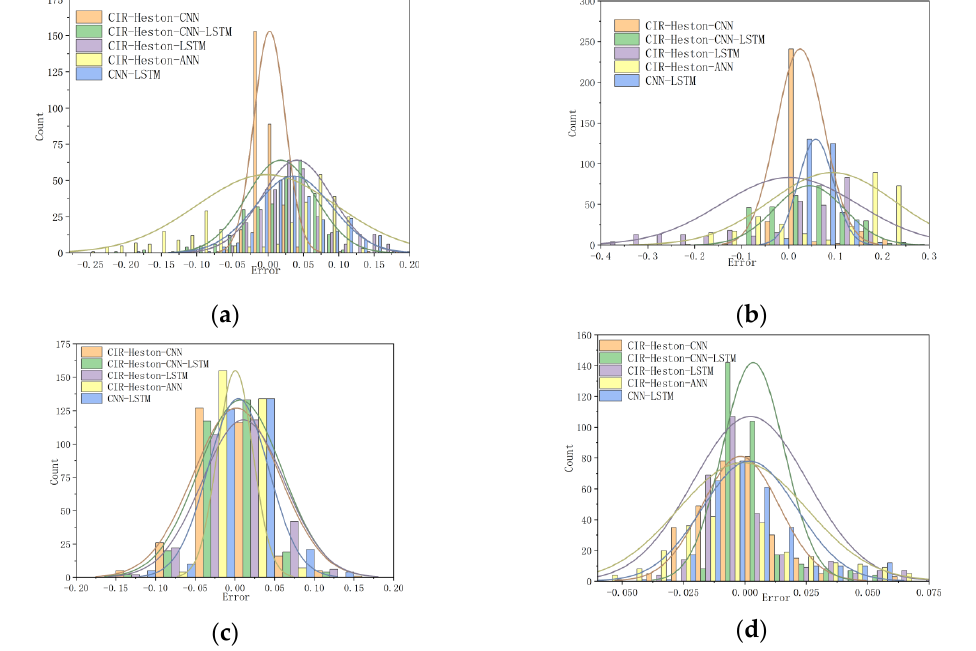
Figure 9 . Error distribution ( a ) of unnoisy call option; ( b ) of noisy ‐ up call option; ( c ) of unnoisy Figure 9. Error distribution ( a ) of unnoisy call option; ( b ) of noisy-up call option; ( c ) of unnoisy put put option; and ( d ) of noisy ‐ up put option. option; and ( d ) of noisy-up put Table 8. Call option model robustness tests for the descriptive statistic.